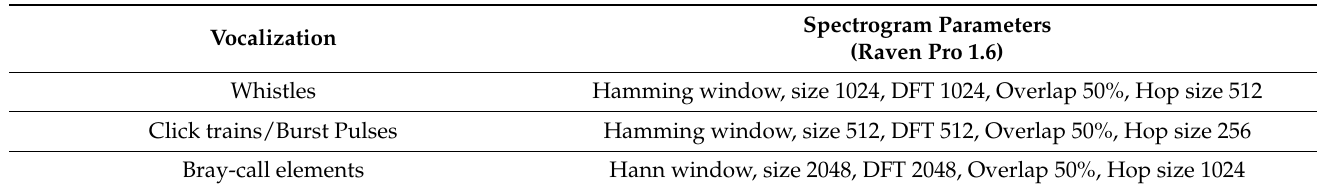
Table 1. Spectrogram setting used for each vocalization type in Raven Pro